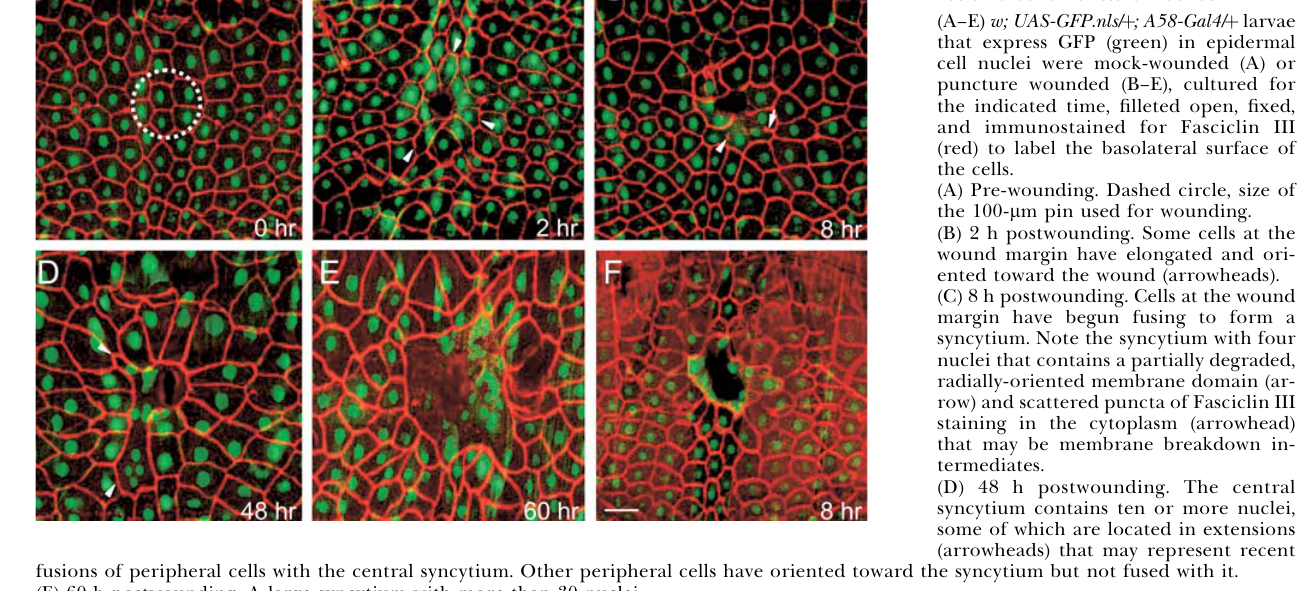
Figure 3. Epidermal Cell Orientation and Fusion around Puncture Wounds (A–E) w; UAS-GFP.nls/ þ ; A58-Gal4/ þ larvae that express GFP (green) in epidermal cell nuclei were mock-wounded (A) or puncture wounded (B–E), cultured for the indicated time, filleted open, fixed, and immunostained for Fasciclin III (red) to label the basolateral surface of the cells. (A) Pre-wounding. Dashed circle, size of the 100- l m pin used for wounding. (B) 2 h postwounding. Some cells at the wound margin have elongated and ori- ented toward the wound (arrowheads). (C) 8 h postwounding. Cells at the wound margin have begun fusing to form a syncytium. Note the syncytium with four nuclei that contains a partially degraded, radially-oriented membrane domain (ar- row) and scattered puncta of Fasciclin III staining in the cytoplasm (arrowhead) that may be membrane breakdown in- termediates. (D) 48 h postwounding. The central syncytium contains ten or more nuclei,